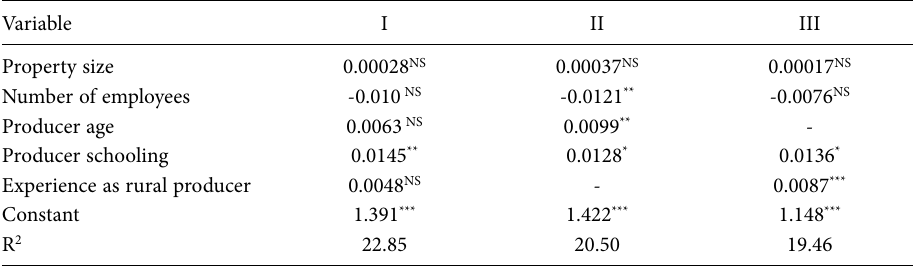
Table 4. Factors associated to technical efficiency in citrus producing properties in Sao Paulo state – OLS